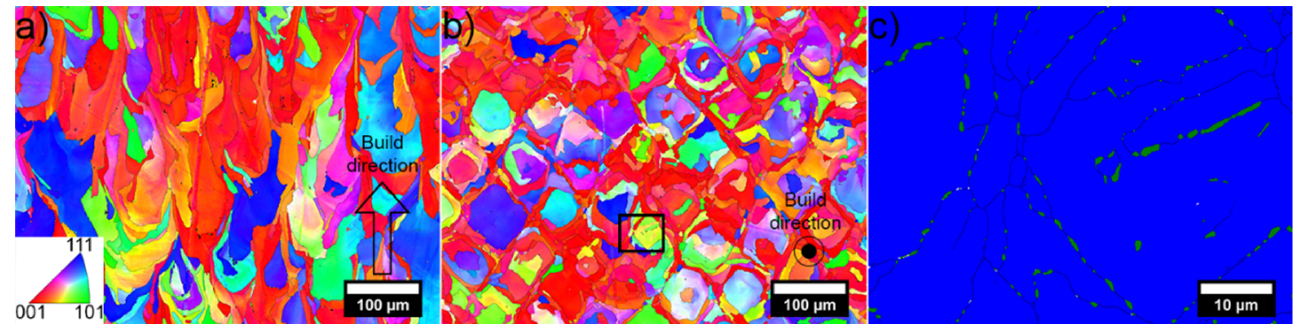
Figure 7. EBSD analysis of the annealed SS446 ferritic stainless-steel showing ( a ) EBSD orientation map along the build direction, ( b ) EBSD orientation map perpendicular to the build direction. The